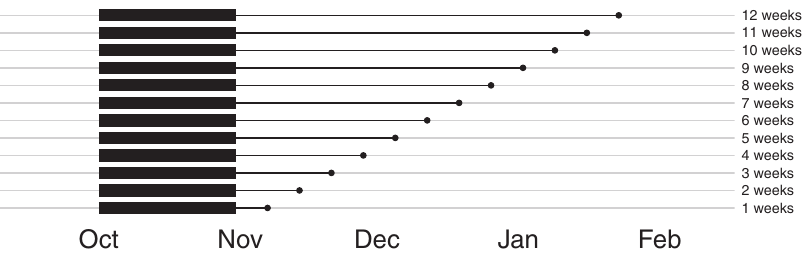
Fig. 2 Illustration of the analytical framework. This fi gure highlights the analytical framework presented in the main text. Part A highlights the “ most current ” approach, which is used to select the data shown in Fig. 3. Part B highlights the “ month strati fi ed ” approach used for Figs. 4 and 5. The Y axis shows the number of weeks of extrapolation for each scenario, while the x axis shows a range of model date — the date on which a model was released. The thick band in each plot highlights the 4-week window of model dates used for each extrapolation week value. The thin line shows the period for which each set of models is extrapolating before errors are calculated. In the top panel, the most recent 4 weeks of model dates are used for each extrapolation length. Therefore, for 1-week errors, models from January and February 2021 were used, whereas for 12-week errors, models from October and November 2020 were used. In the bottom panel, models from October are used in all cases. The analytic strategy highlighted in the top panel provides the most recent evidence possible for each extrapolation length. The strategy at the bottom allows for a more reliable assessment of how errors grow with increased extrapolation